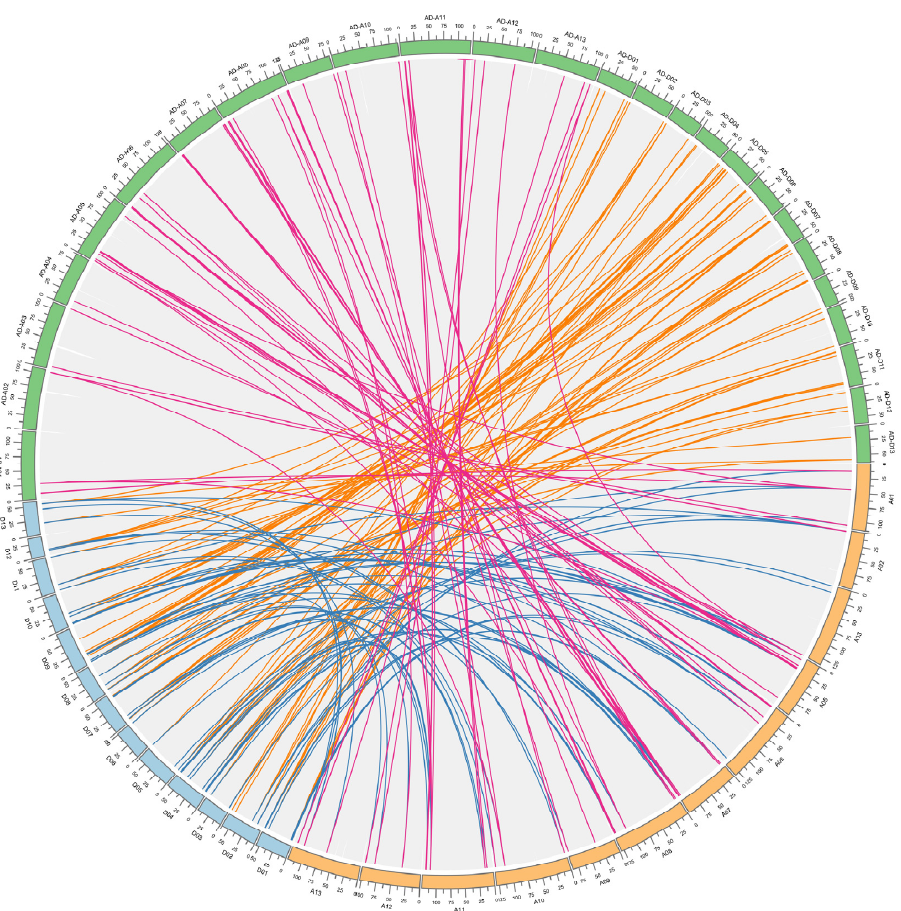
Figure 4. The analysis of synteny and collinearity in Ga , Gr , and Gh . The chromosomes of Ga , Gr , and Gh represents orange, light blue, and grass green colors, respectively. The lines of blue, orange and rose lines represent the GrD/GaA, GhAD/GrD, GhAD/GaA genomes,